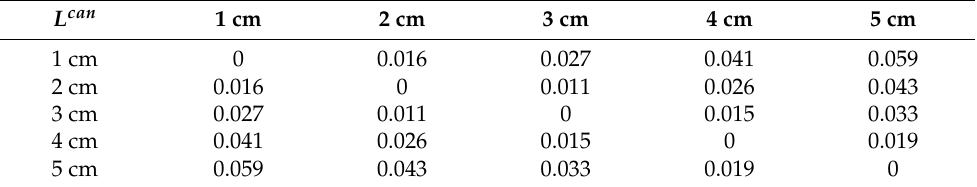
Table 2. Relative brightness temperature deviations ψ ab for two models with different tumor localiza- tions in depth ( L ( can )